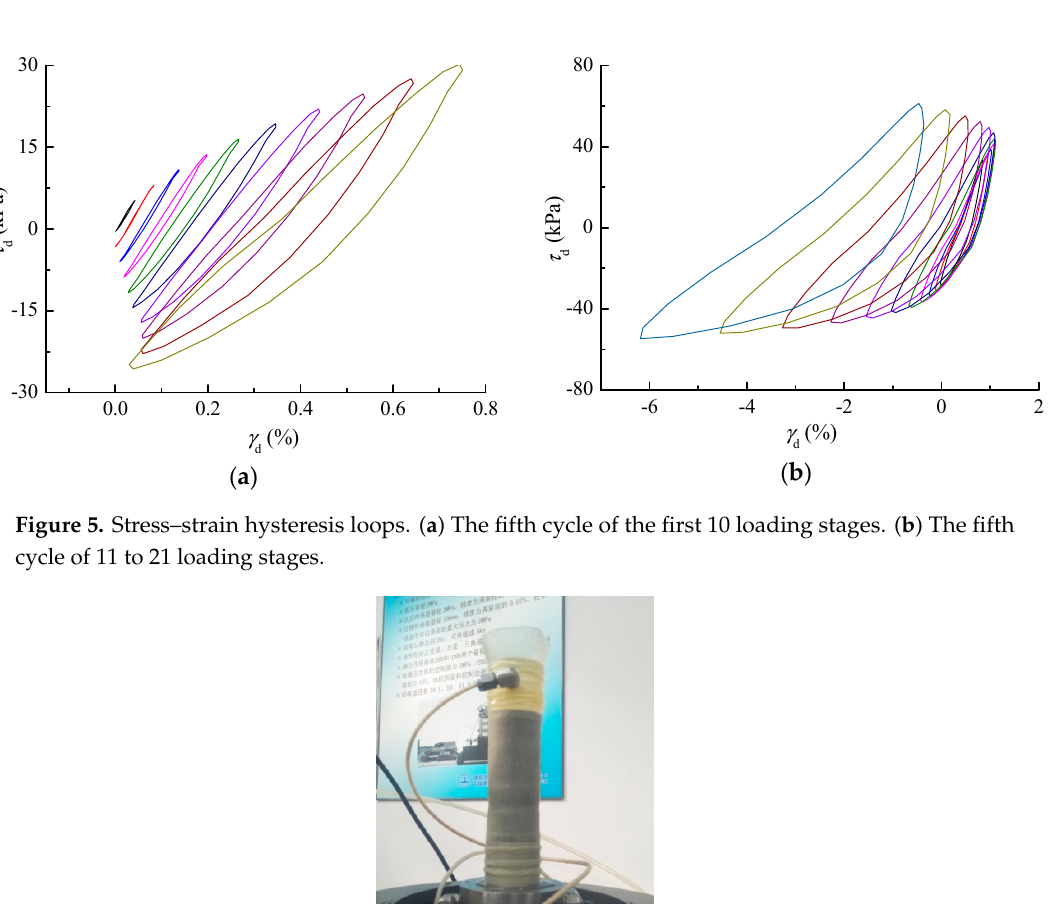
( b ) Figure 7. Shear modulus and damping ratio versus shear strain amplitude for the sand-sawdust mixture with various sawdust contents with the confining pressure of 100 kPa. ( a ) Shear modulus versus shear strain amplitude; ( b ) damping ratio versus shear strain amplitude. 3.3. Effect of Confining Pressure In Figure 8, the effect of conf ining pressure was depicted for six specimens with sawdust contents equal to 33% by mixture weight. As expected, the increase in the shear strain amplitude reduced the shear modulus and increased the damping ratio. When